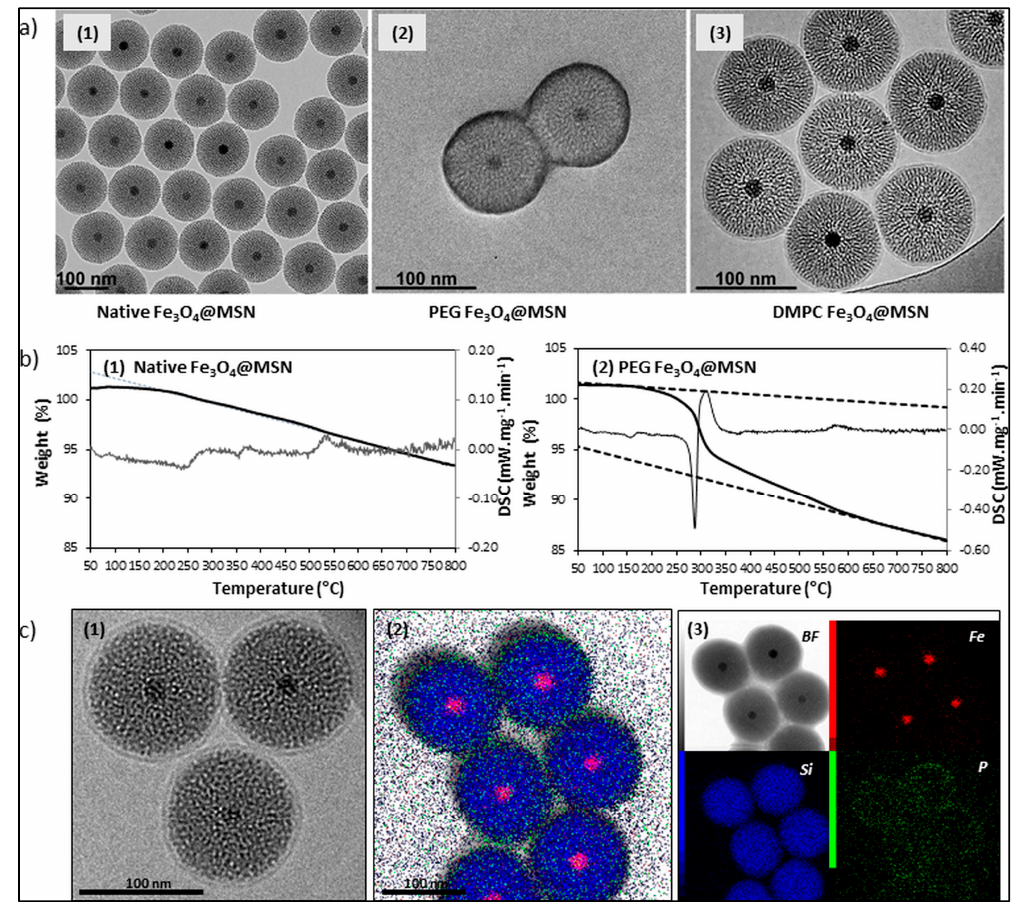
Figure 3. Characterization of native, polyethylene glycol (PEG)-grafted, and lipid-coated Fe 3 O 4 @MSN. ( a ) Transmission electron microscopy (TEM) imaging of (1) native Fe 3 O 4 @MSN, (2) PEG-grafted Fe 3 O 4 @MSN, and (3) lipid-coated Fe 3 O 4 @MSN with dimyristoyl phosphatidylcholine (DMPC) lipids, showing a primary diameter of 100 nm, with very homogeneous shape, porosity, and coverage.